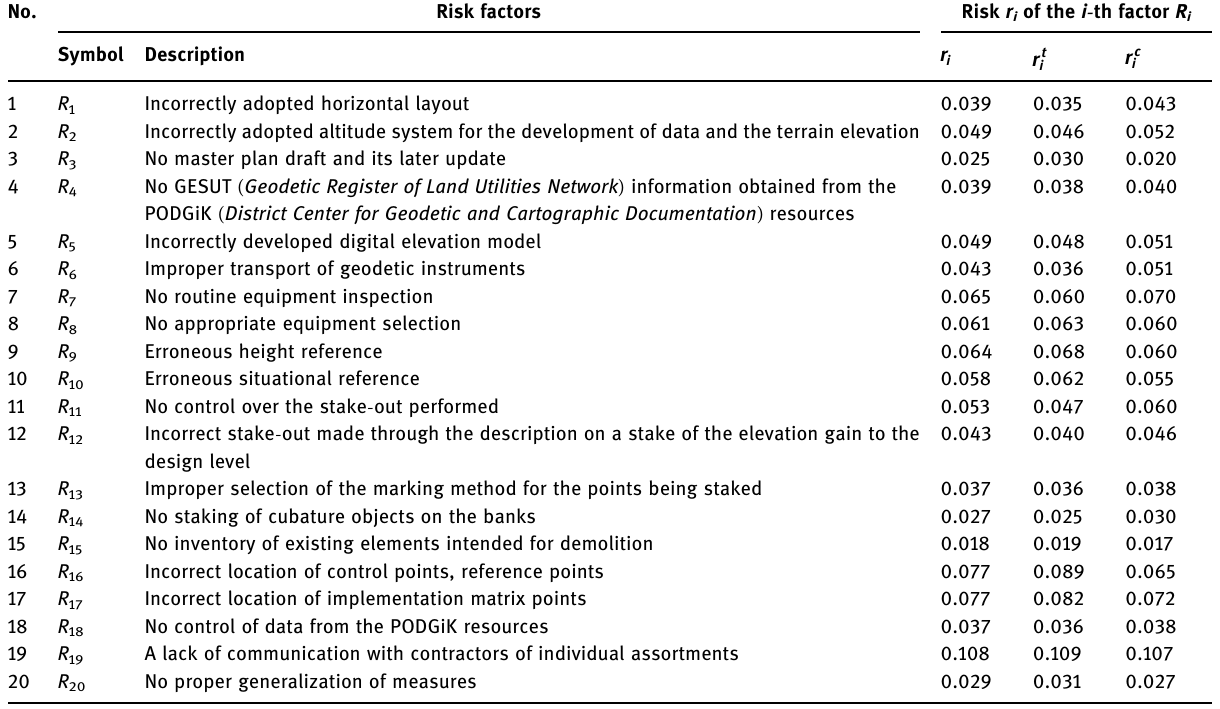
Table 1: Risk factors with speci fi c risk values that may accompany their occurrence No. Risk factors Risk r i of the i - th factor R